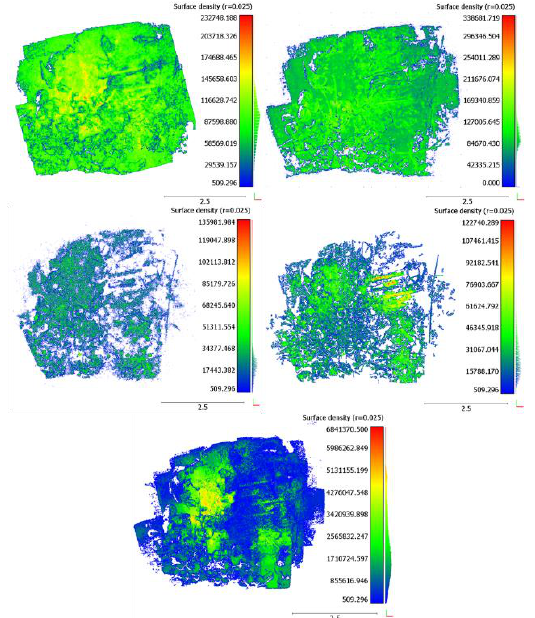
Figure 5: Surface Density across the Dense Clouds. Upper left: Photoscan, Upper right: Reality Capture, Middle Left: 3D Zephyr, Middle right: VSFM, Bottom: SURE